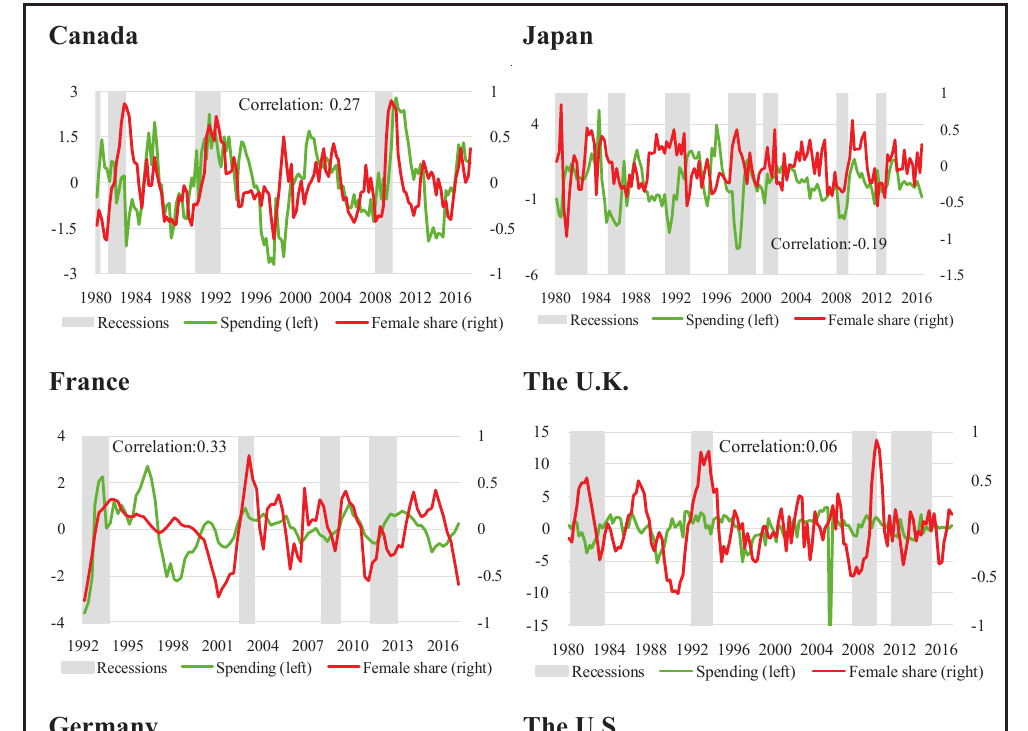
Figure 4 Fiscal spending and female share of total